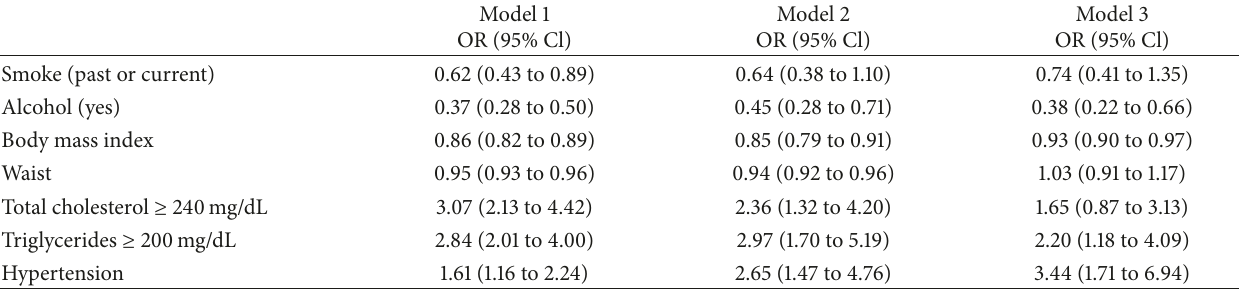
Table 2: Odds ratios (95% CI) for different factors (Chinese versus Italians).